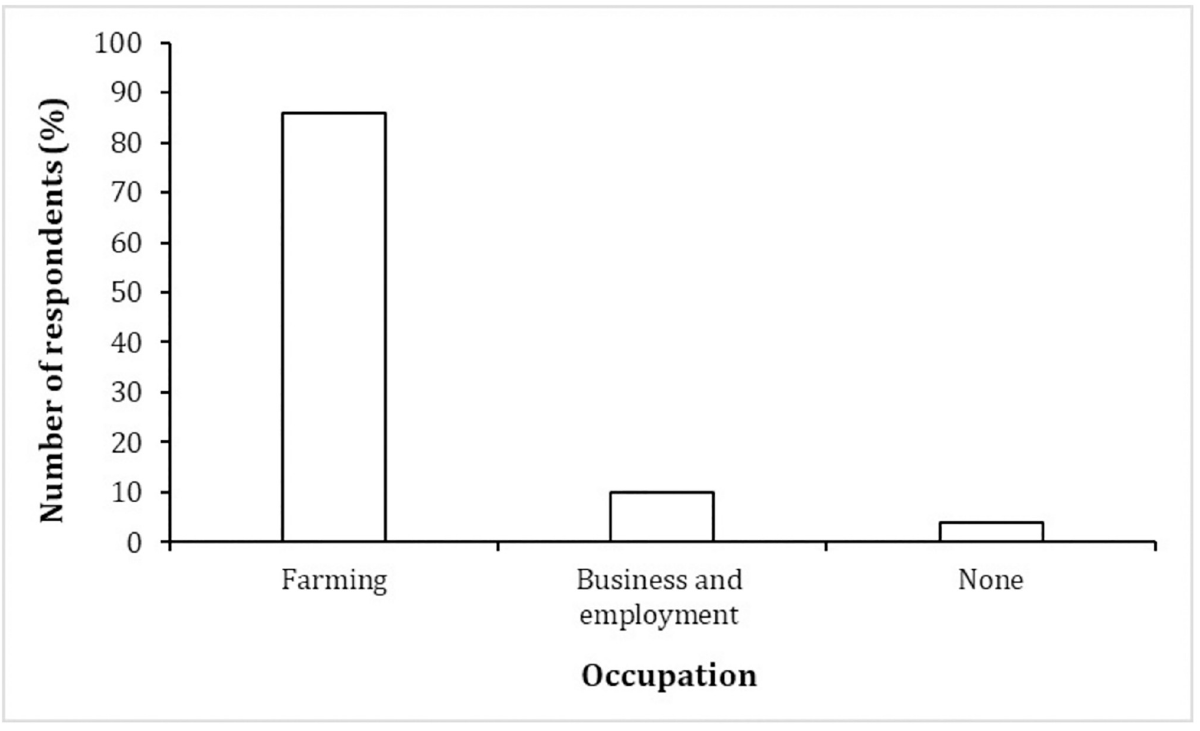
Fig 2. Socio-economic activities in